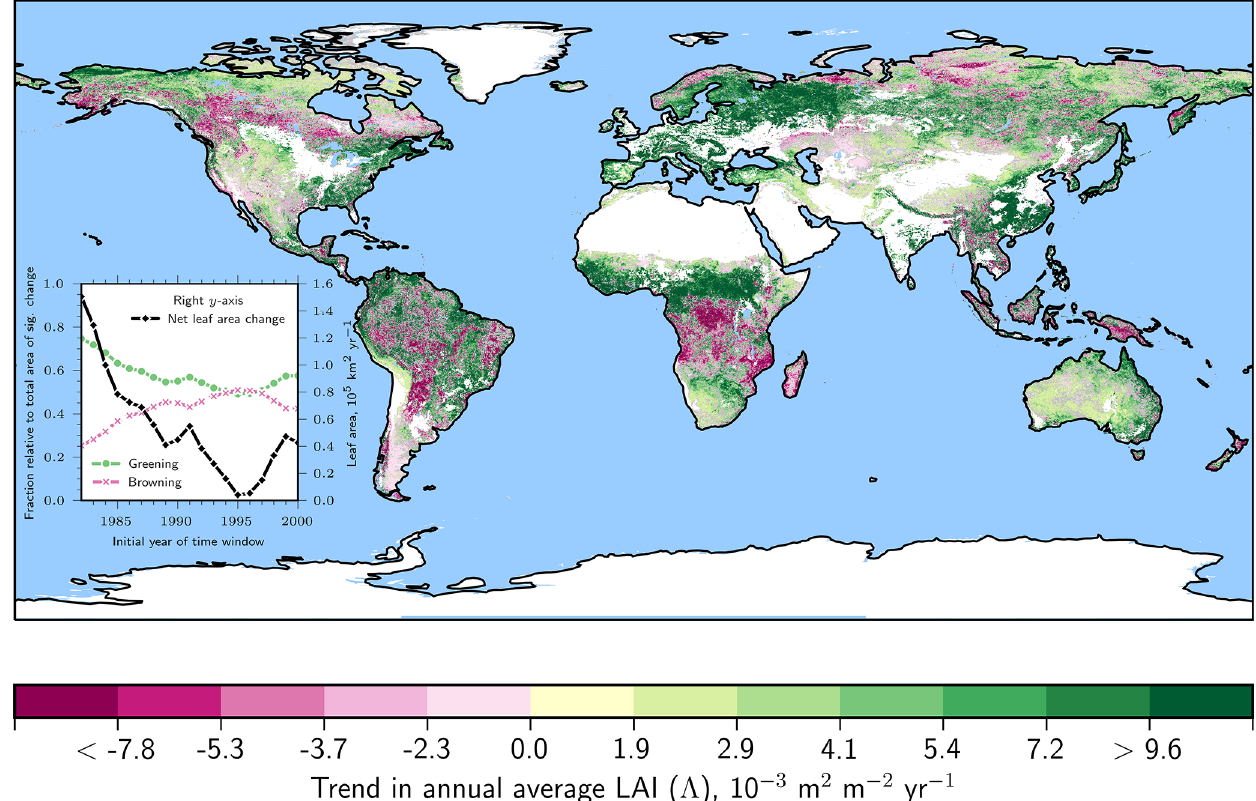
Figure 2. Natural vegetation exhibits patterns of opposing long-term LAI trends with rising CO 2 . Global map of statistically significant (Mann–Kendall test, p < 0 . 1) annual average LAI trends (denoted (cid:51) ) for the entire period 1982–2017 (GIMMS LAI3g, color-coded). Areas of non-significant change are shown in gray. Anthropogenic vegetation (defined as croplands, “Materials and methods”) is masked in white. Other white areas depict ice sheets or barren land. The inset line plot illustrates the change in fraction of positive (green dots) and negative (red crosses) (cid:51) relative to the total area of significant change and net leaf area change (black squares; right y axis) for time windows of moving initial year (final year fixed at 2017). The x axis shows the advancing initial year of the time